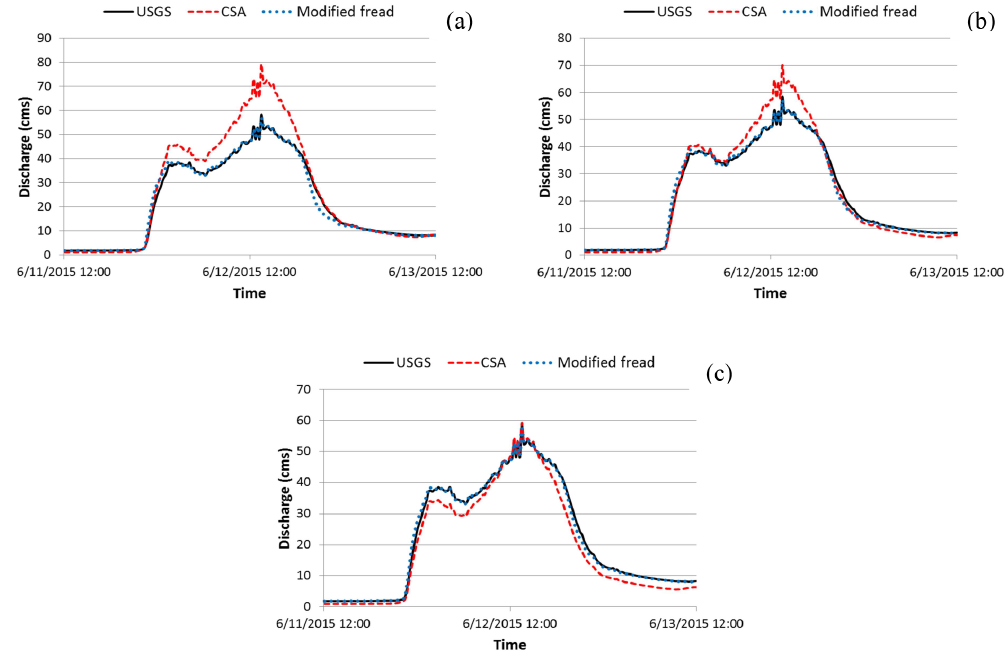
Figure 10. Sensitivity of discharge estimates due to the change in channel bed slopes: (a) 0.00039, (b) 0.0005, and (c) 0.0007 for the selected Event